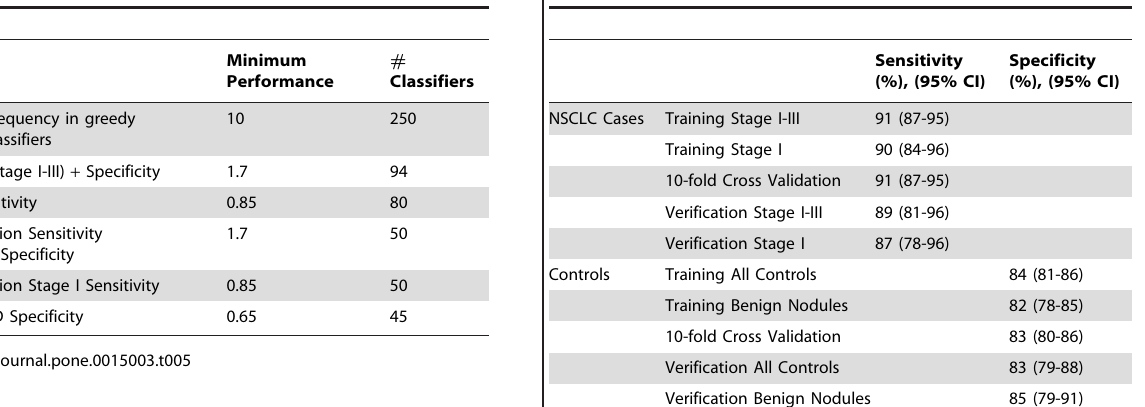
Table 5. Criteria for algorithm performance on training and cross-validation.